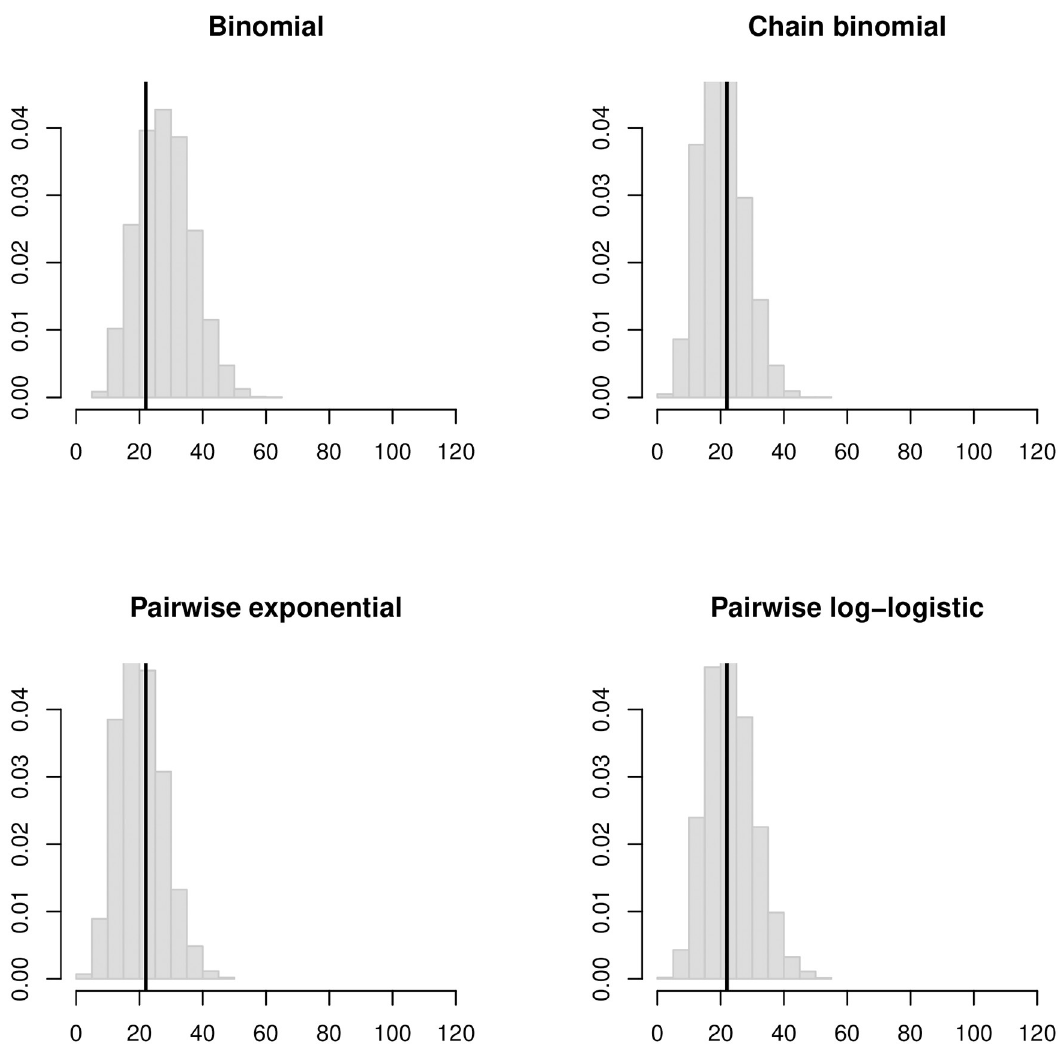
Fig 6. Histogram of simulated final outbreak sizes in the LA households based on SAR estimates assuming a 4-day infectious period. Vertical black lines indicate the observed final size of 22